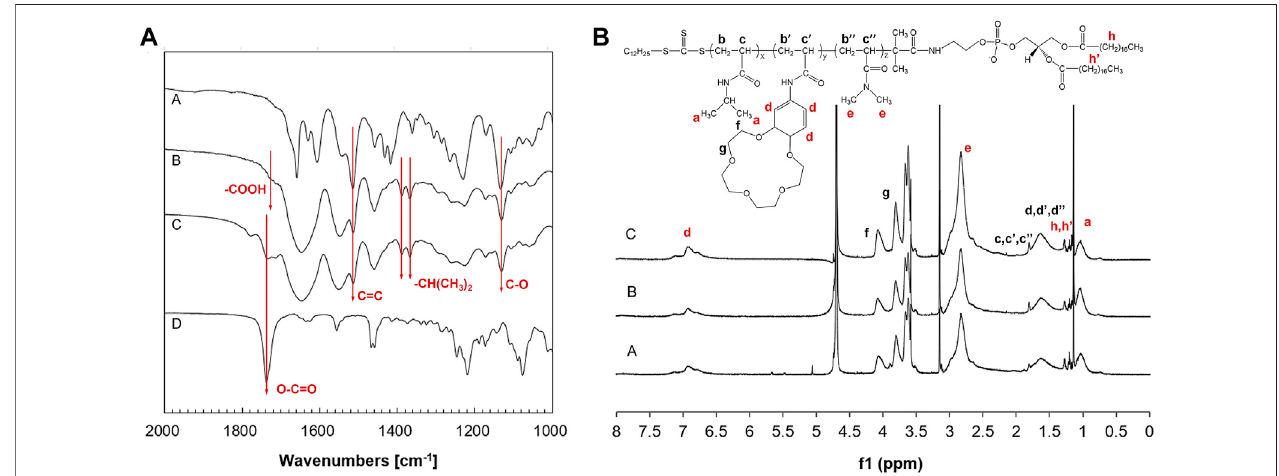
FIGURE 1 | (A) FT-IR spectra of B15C5Am (Curve A), PNDB (Curve B), PNDB-b-DSPE (Curve C), and DSPE (Curve D). (B) 1H NMR spectra of PNDB-b-DSPE1 (Curve A), PNDB-b-DSPE2 (Curve B), and PNDB-b-DSPE3 (Curve C) block